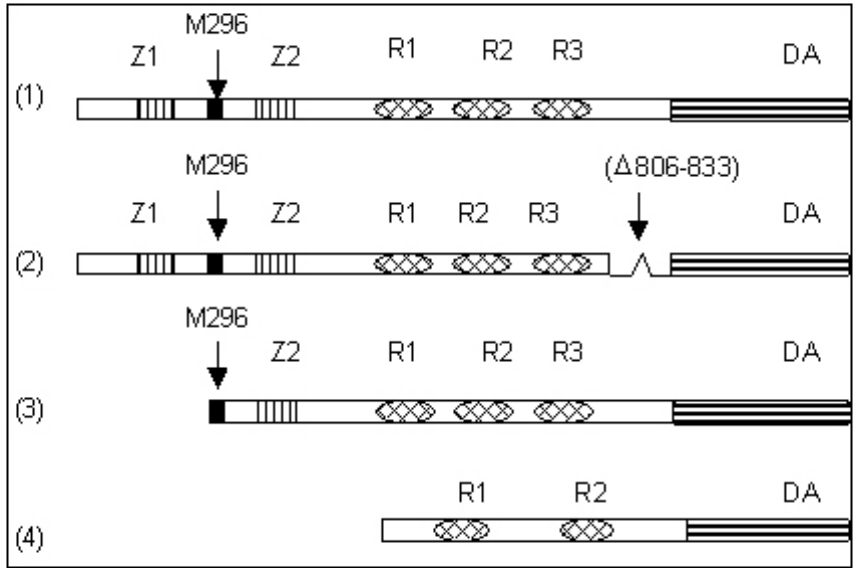
FIGURE 2 . Structure of four of the different forms of ADARs. Z1, Z2: Z-DNA binding domains. R1, R2, R3: double-stranded RNA binding domains (dsRBDs). DA: deaminase domain. M296: Methionine at position 296. As shown here, all ADARs have N-terminal dsRBDs and a highly conserved C-terminal deaminase domain. The presence of Z-DNA binding domains, the length of the N-terminal region, the number of dsRBDs, and the amino acid sequences spanning the region between the dsRBDs and the deaminase domain vary among the different ADARs. (1) Full-length ADAR1a: transcription product of ADAR1 gene. It is a protein having 1226 amino acids, has 2 Z-DNA binding domains, and 3 dsRBDs. (2) Full-length ADAR 1b: transcription product of ADAR1 gene. It is similar to full-length ADAR1a, but has a deletion of 28 aminoacids ( ∆ 806 – 833) towards the C-terminus. (3) Truncated ADAR 1a (M296 – ADAR 1a): transcription product of ADAR1 gene. It is a shorter version of full-length ADAR 1a.